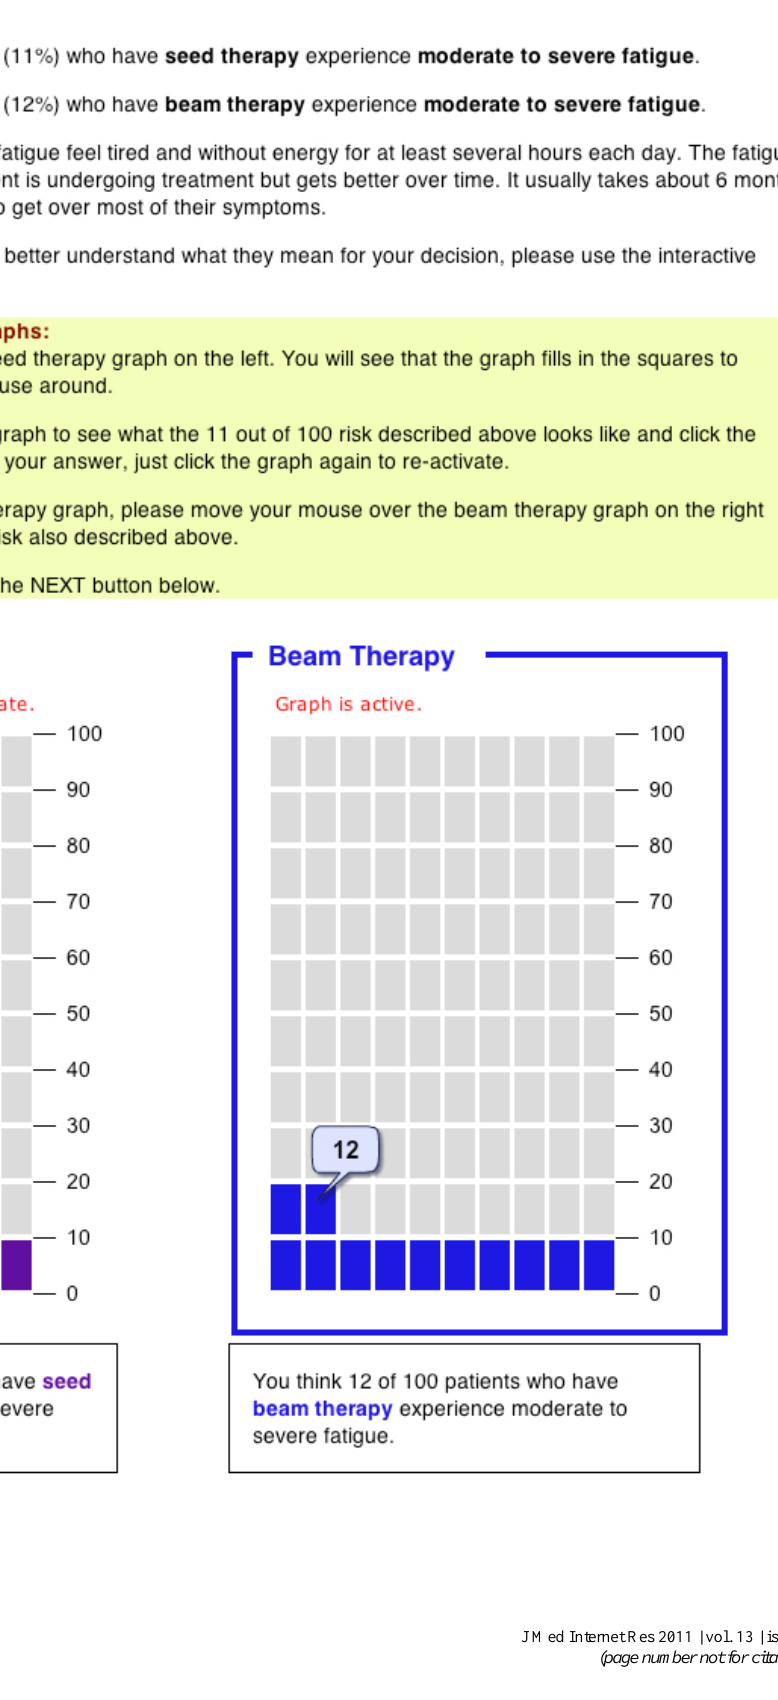
Figure 2. Screen image of the interactive graphing